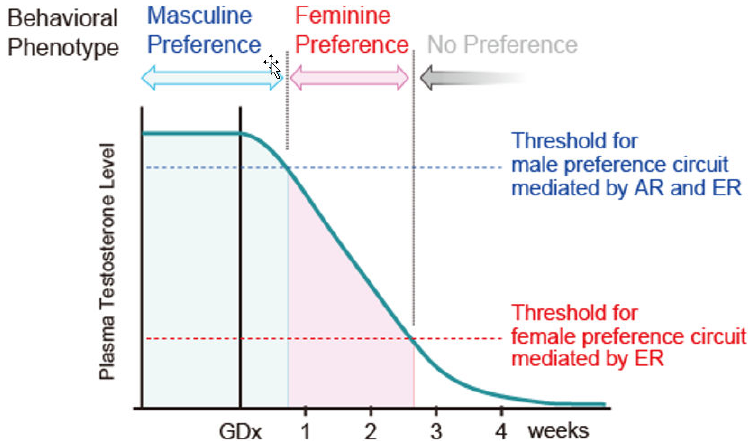
Figure 4. Model explaining the transient reversed preference observed after male rat castration. We hypothesize that the male rat brain has both circuits for expression of masculine and feminine preference. In gonadally intact males, their circulating testosterone is sufficient to activate the masculine circuit, displaying dominant masculine preferences, and obscuring feminine preferences. However, the declining level of circulating testosterone after castration becomes insufficient to activate the masculine circuit, while still activating the feminine circuit because of its lower threshold in steroid sensitivity, therefore leading to a temporal feminine preference as the level falls below the